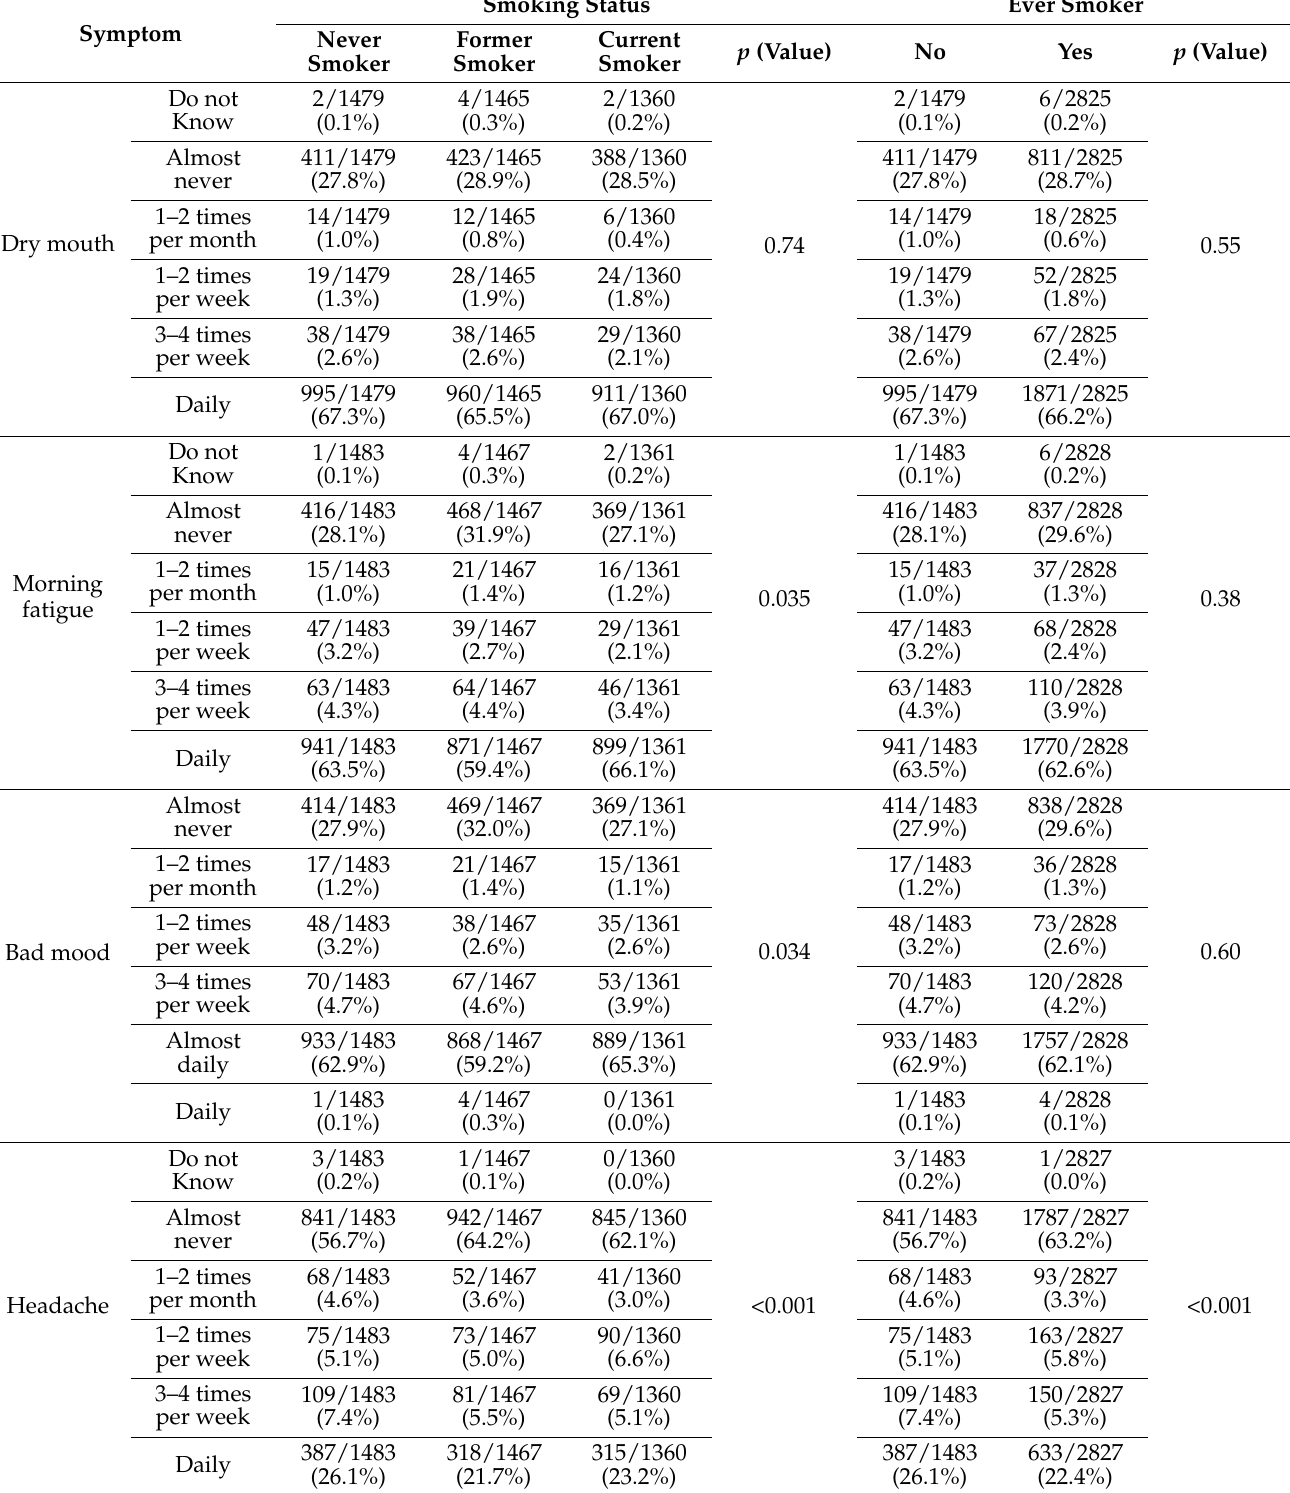
Table 4. Sleep-apnea-related symptoms according to the smoking status of the